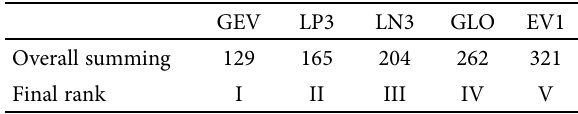
Table 6. Final results of goodness of fit test (ranking of probability distributions)